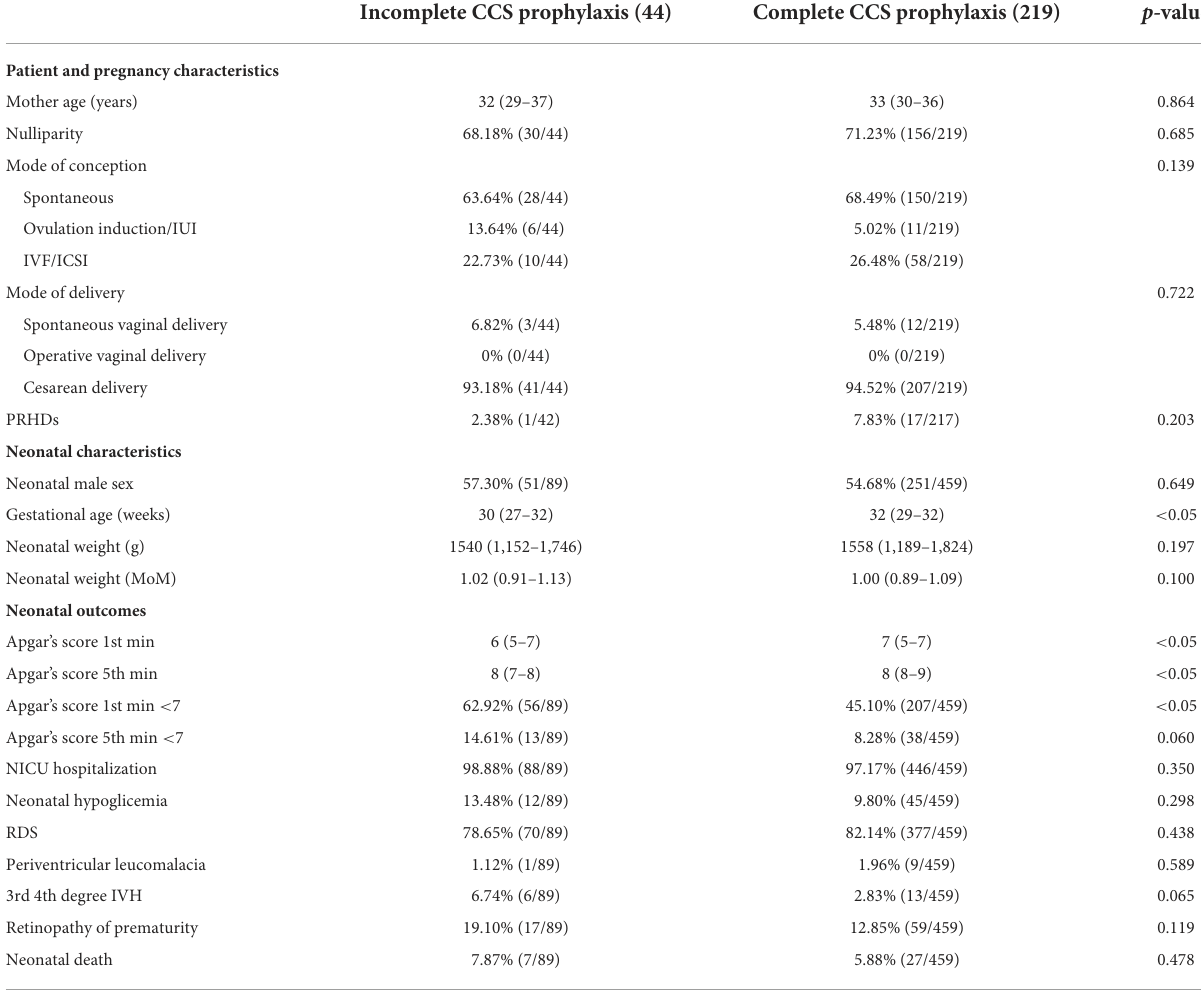
TABLE 4 Population description of multiple pregnancies stratified by complete or incomplete corticosteroid (CCS) prophylaxis. Incomplete CCS prophylaxis